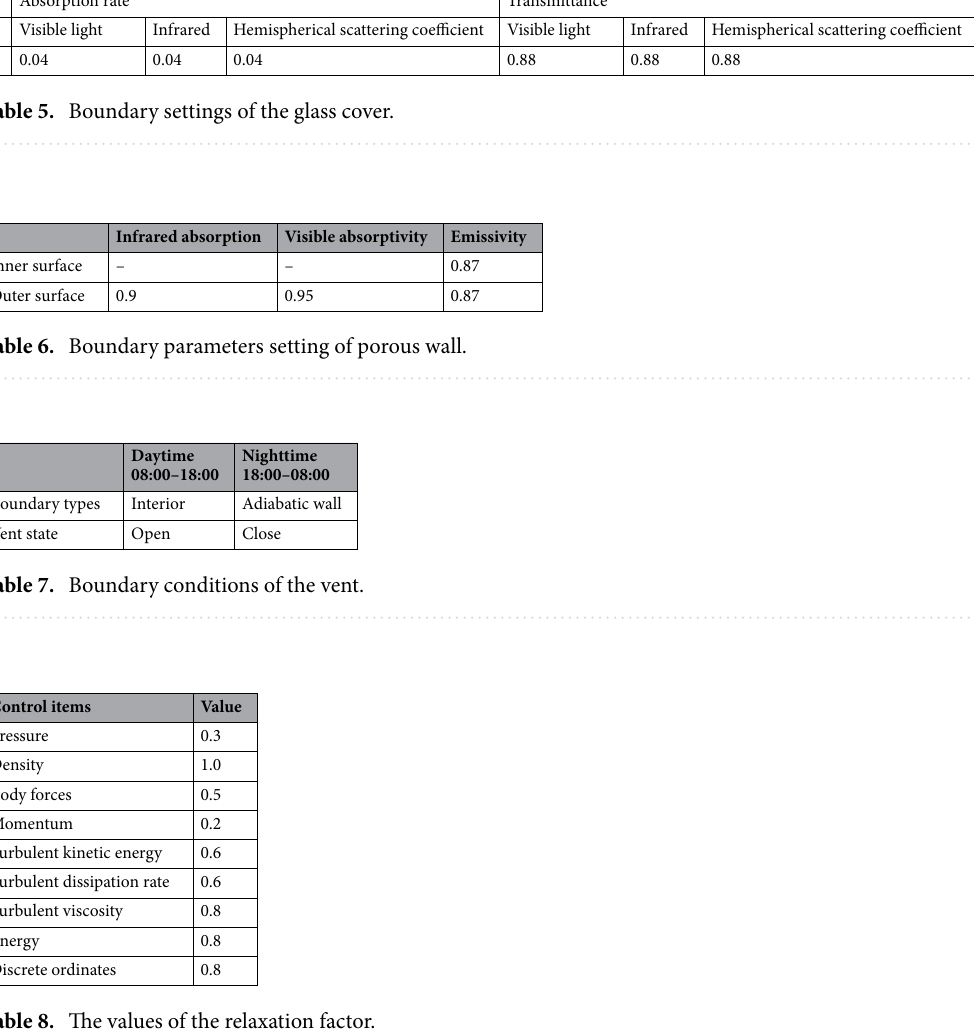
Table 8. The values of the relaxation